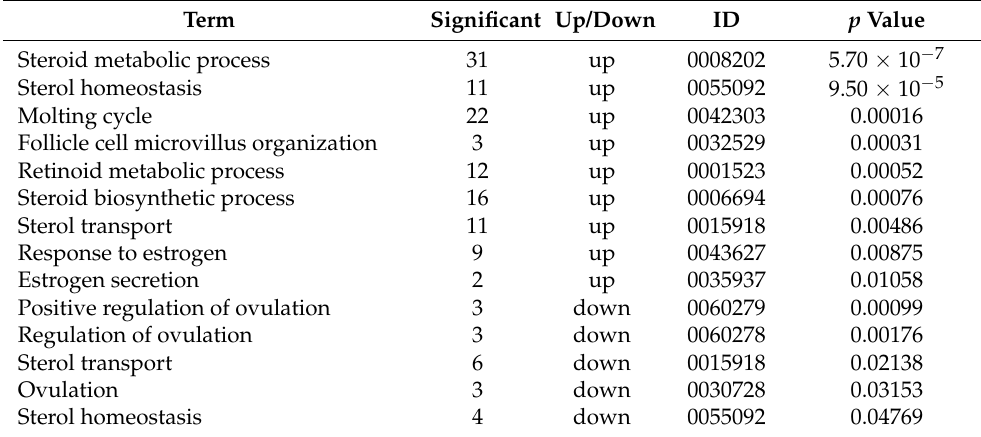
Table 1. The GO term of related to ovarian development in the HC_O vs. CG_O group. Term Significant Up/Down ID Steroid metabolic process